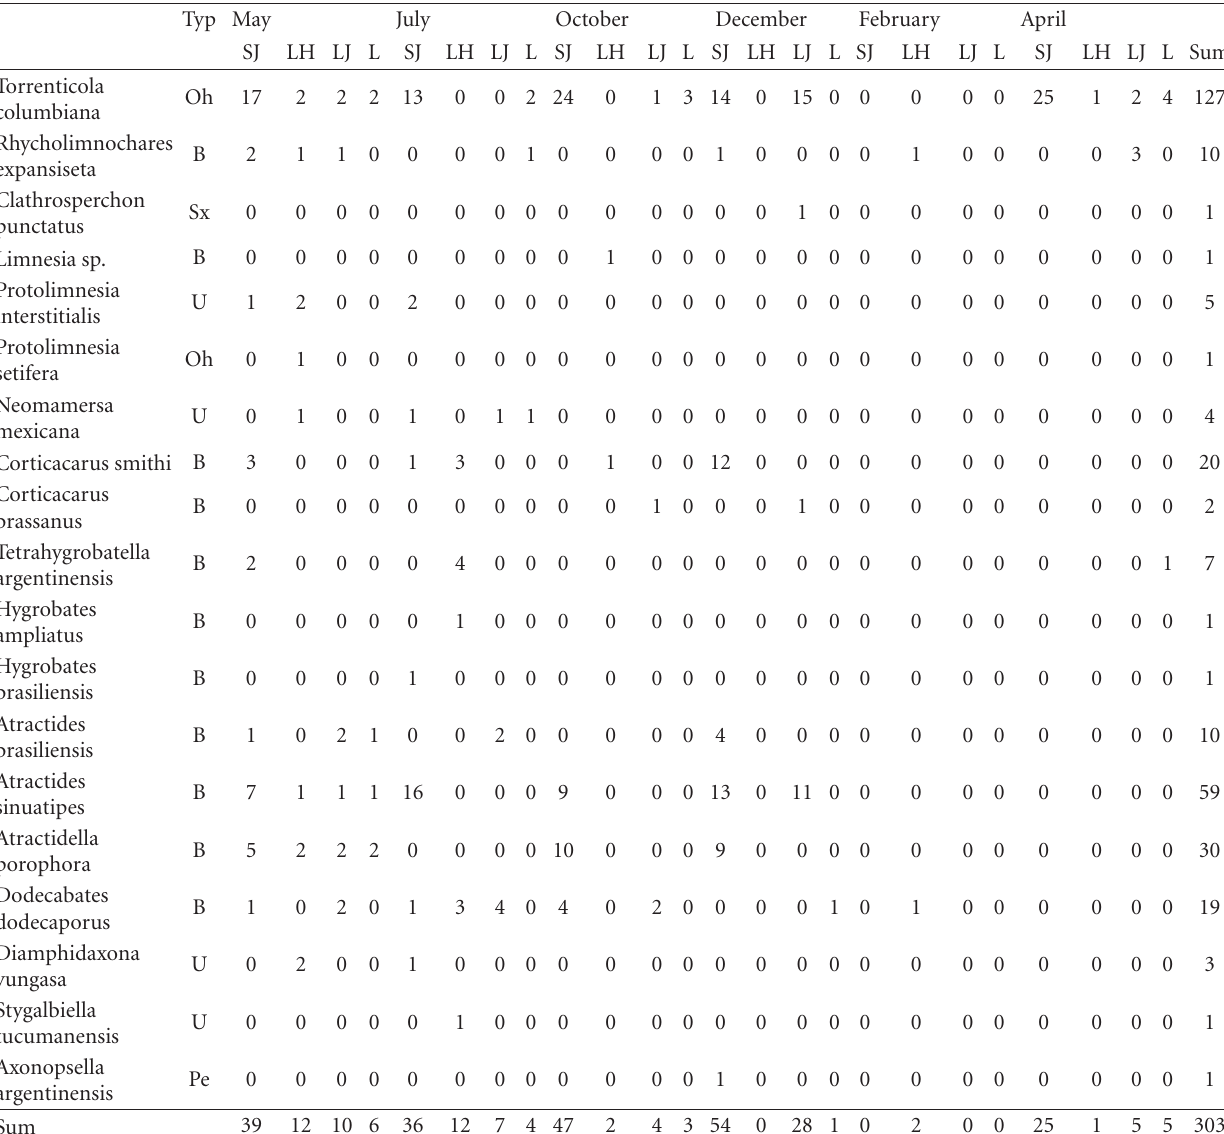
Table 2: Hydrachnidia from Lules Streams (Tucum´an, Argentina)